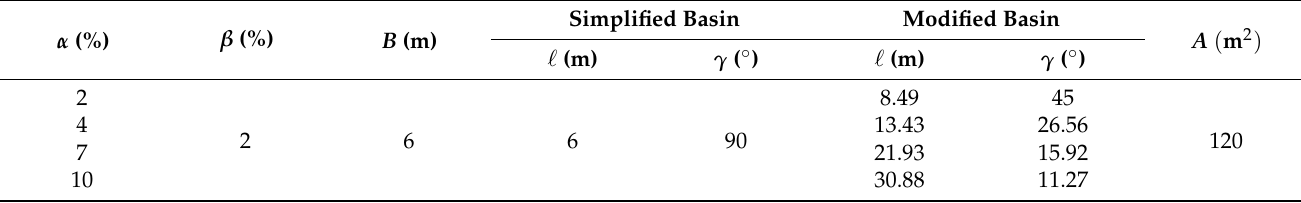
Table 2. Experimental conditions for drainage basins.